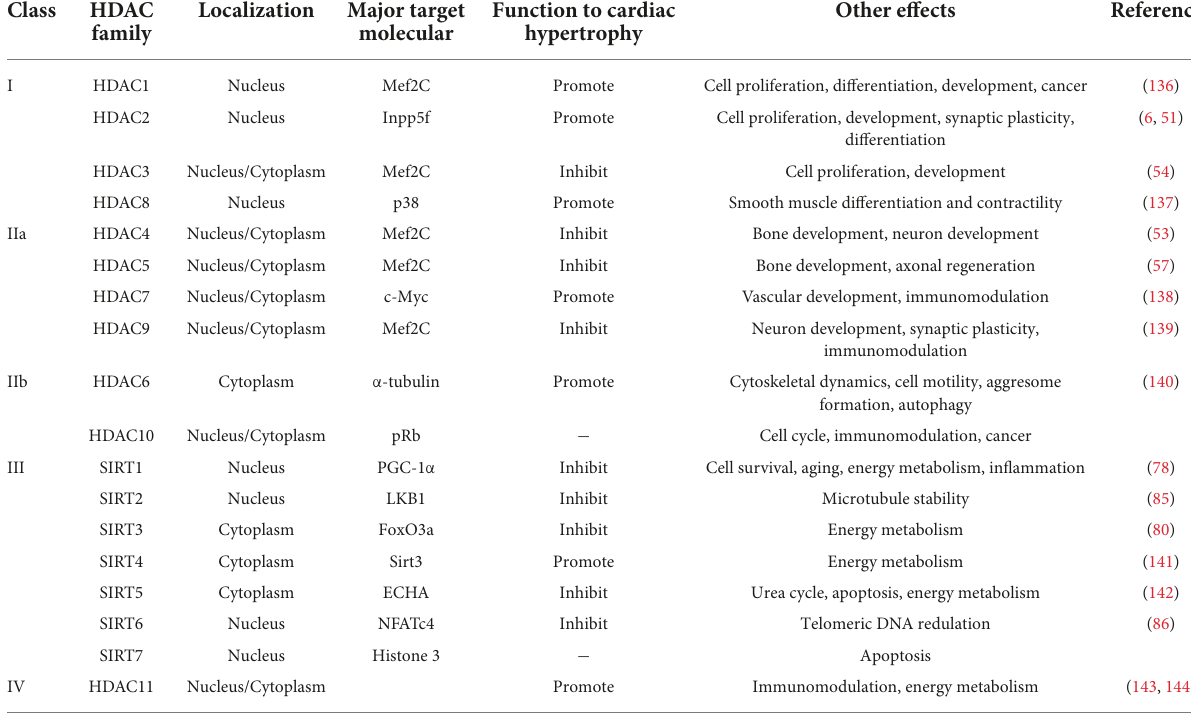
TABLE 1 Different classes of HDAC and a brief introduction of their basic